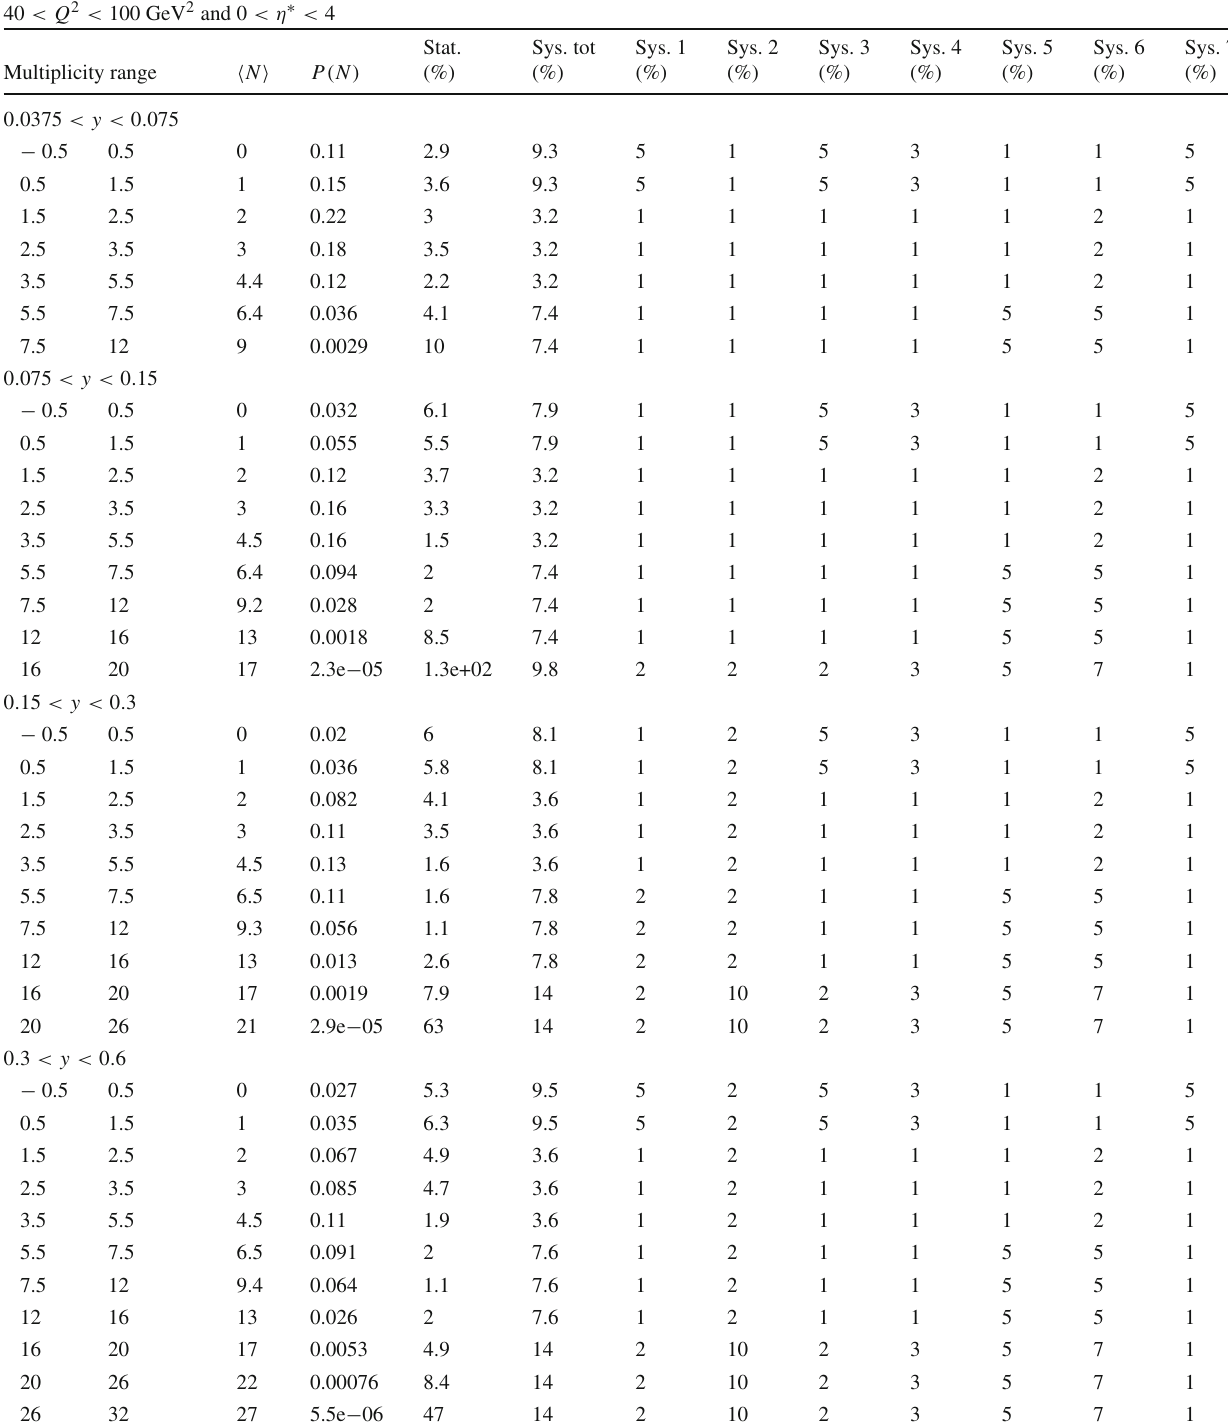
Table 28 Charged particle multiplicity distributions P ( N ) measured √ s = 319GeV with in the ranges of photon virtual- in ep DIS at ity 40 < Q 2 < 100 GeV 2 and charged particle pseudorapidity range Multiplicity distributions in DIS 40 < Q 2 < 100 GeV 2 and 0 < η ∗ <